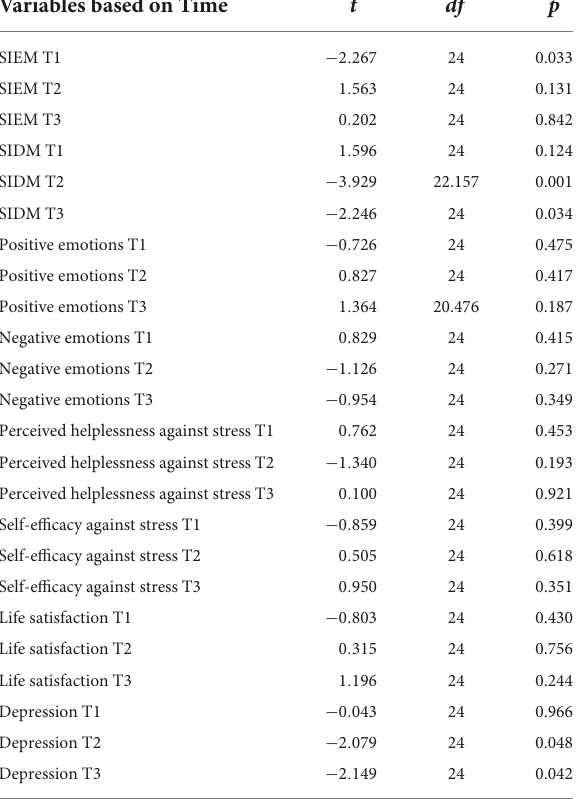
TABLE 5 Independent samples t -test coefficients for the mean comparison of control and intervention groups as a function of time. Variables based on